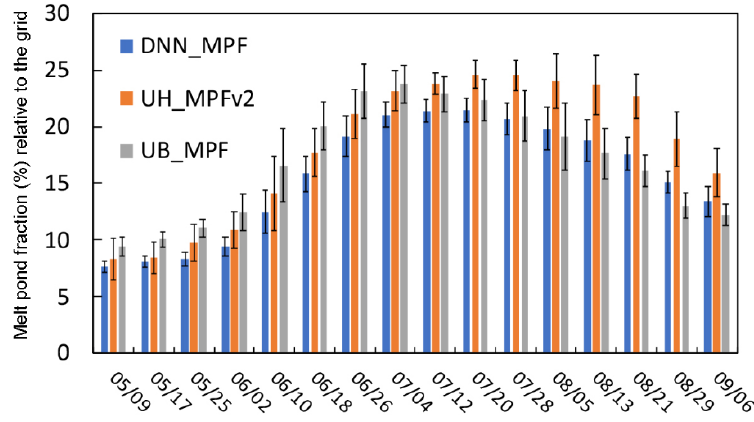
Figure 15. Evolution of the DNN_MPF, UH_MPF, and UB_MPF relative to the grid in the period of May to September during 2003–2011.